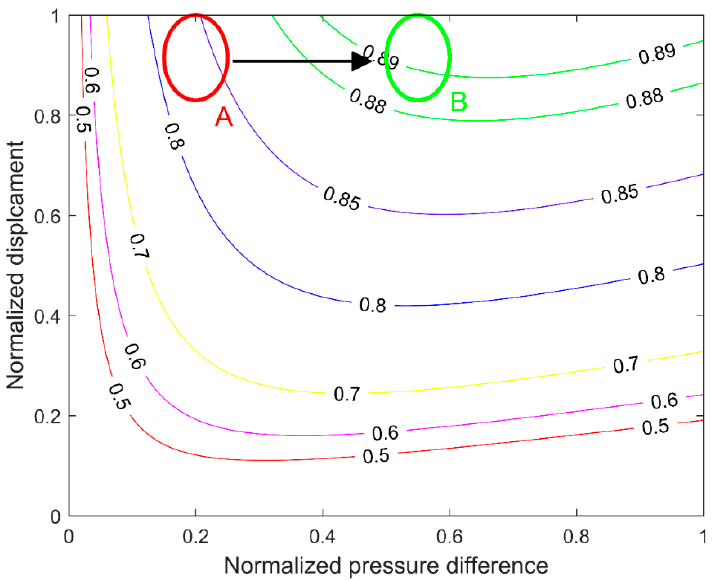
Figure 11. E ffi ciency contours as a function of the normalized pressure di ff erence and displacement in Figure 11. Efficiency contours as a function of the normalized pressure difference and displacement pumping mode. in pumping mode.